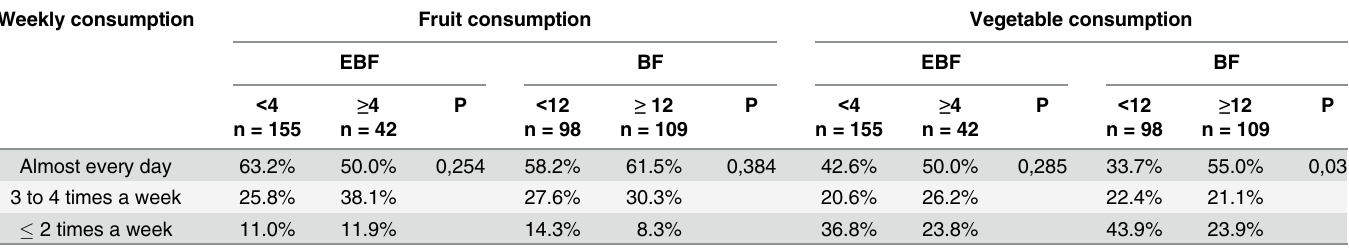
Table 1. Frequency of weekly consumption of fruits and vegetables among children between 4 and 7 years old according to the duration of BF and EBF.